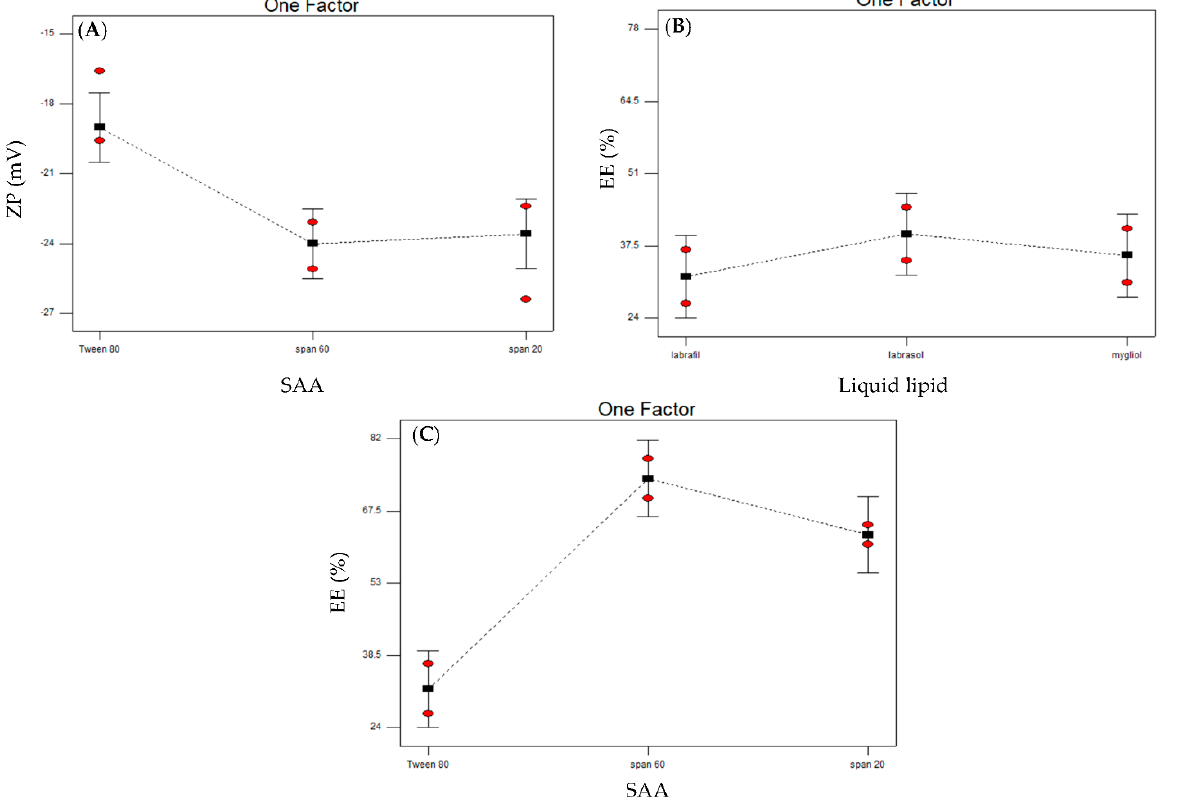
Figure 2. Line plots of the effect of the two significant studied variables: surfactant type on zeta potential ( A ), liquid lipid type on entrapment efficiency ( B ) and surfactant type on entrapment efficiency ( C ).